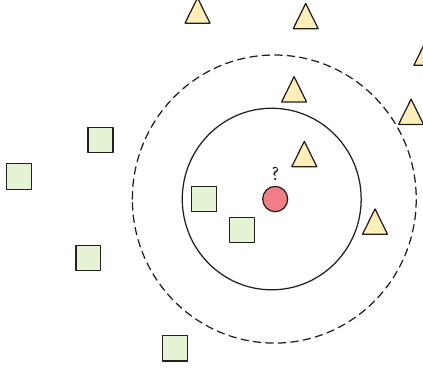
Figure 1: An example of